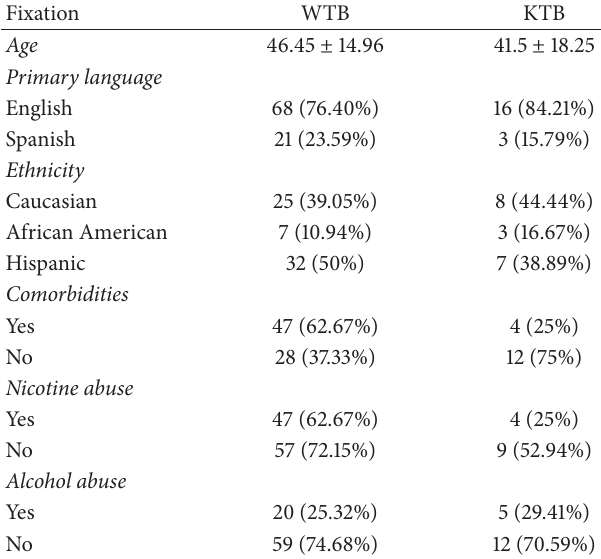
Table 2: Descriptive outcomes of the patient population studied based on what was available in the medical record. Mean age is reported ± the standard deviation. All other outcomes are reported as the number of patients (and as a percentage of the group total).